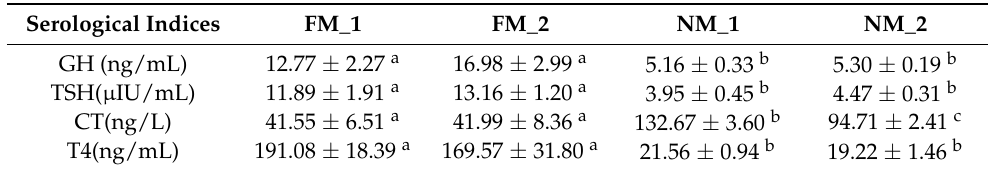
Table 2. Serological indices of FM and NM at different periods.